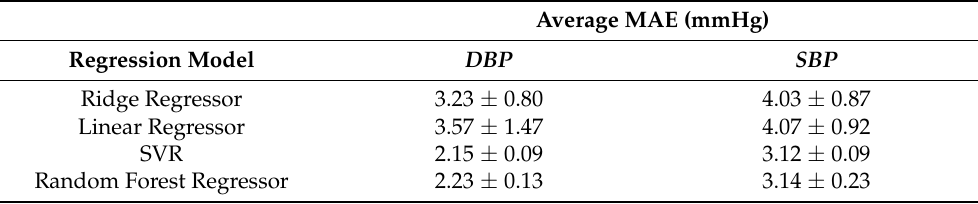
Table 2. Average time-series-split cross-validation errors.